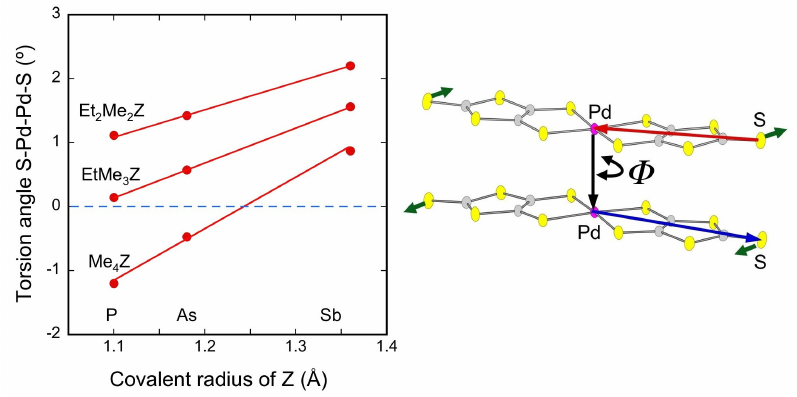
Figure 10. Relation between torsion angle of S–Pd–Pd–S ( Φ ) within the dimer and the covalent radius of the central atom Z ( R Z